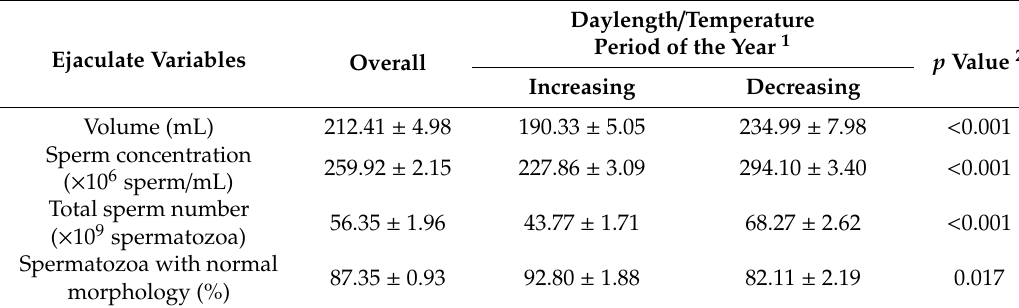
Table 1. Semen variables (mean ± SEM) of the 180 ejaculates used in the experiment (90 ejaculates per daylength / temperature